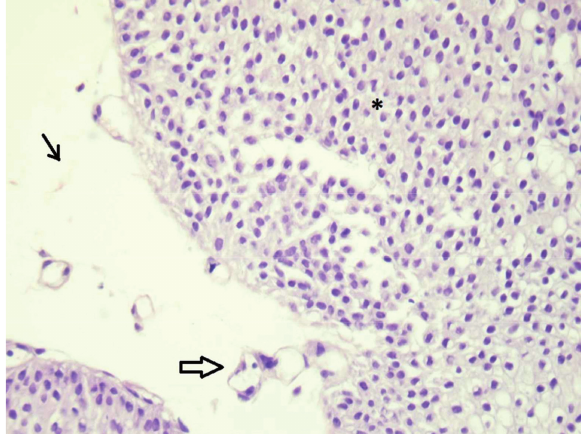
figure 4 - Observe hyperplastic urothelium with several layers of cells (*).Blade itself with marked edema (fine arrow) and dilated capillaries (thick arrow). HE